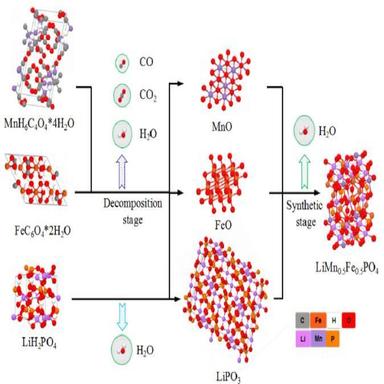
Schematic diagram of synthesis mechanism.